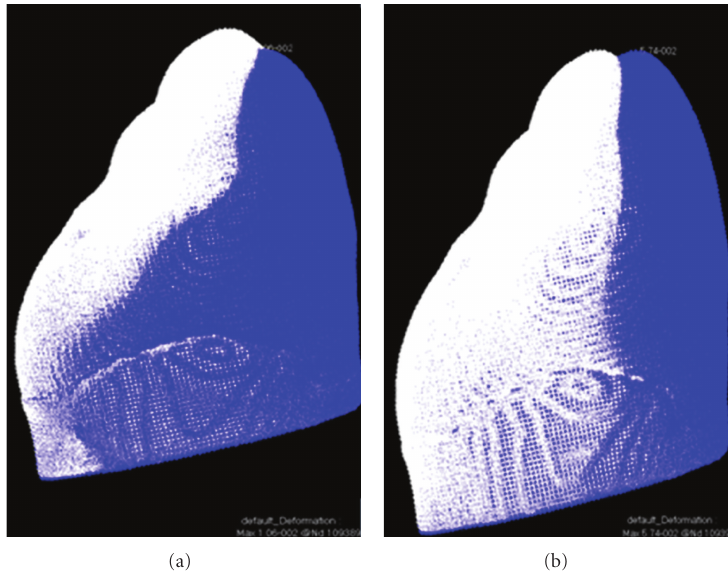
Figure 5: Enamel’s displacement caused by 100 N vertical loading (a) and lateral loading (b).